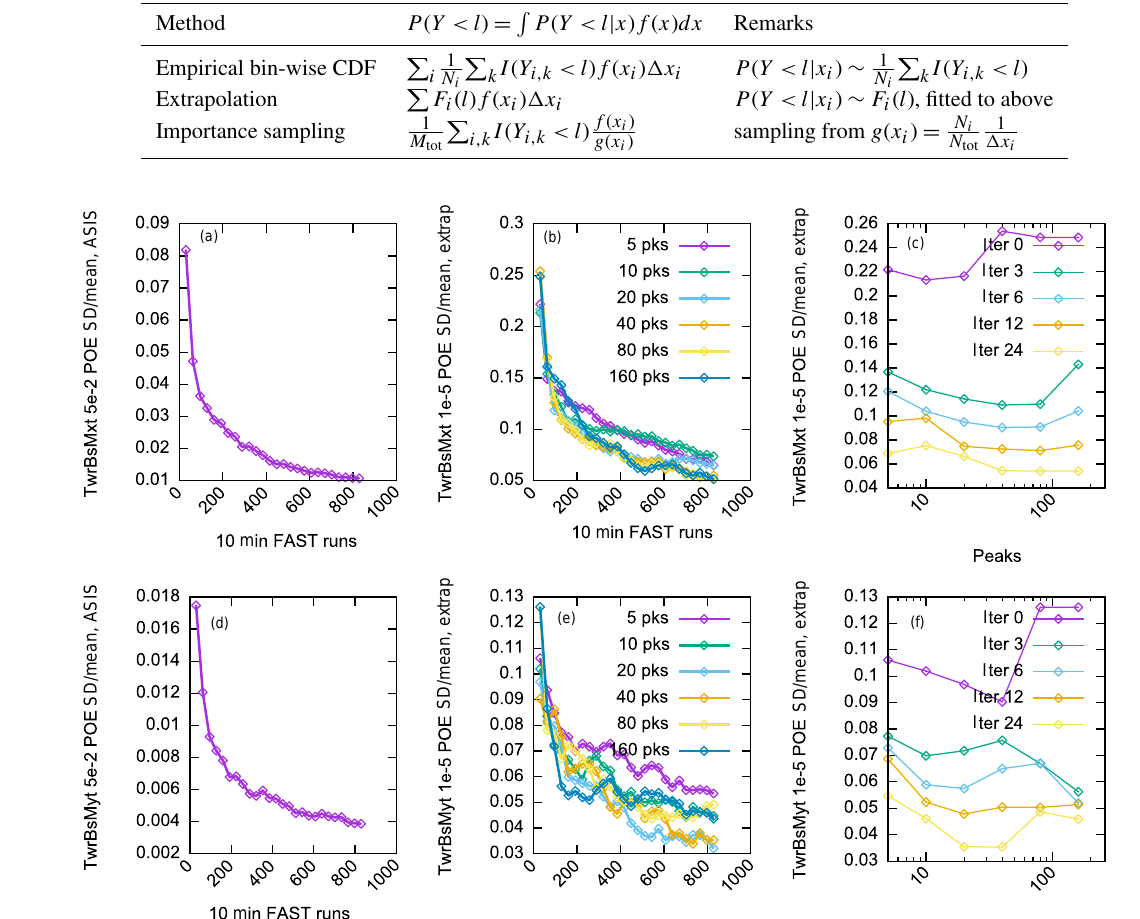
Table 1. Bin-wise empirical cumulative distribution functions provide a bridge from extrapolation, which builds POE from bin-wise fitted distributions F i , and importance sampling, which builds an unbiased estimate from the appropriately defined distribution g .